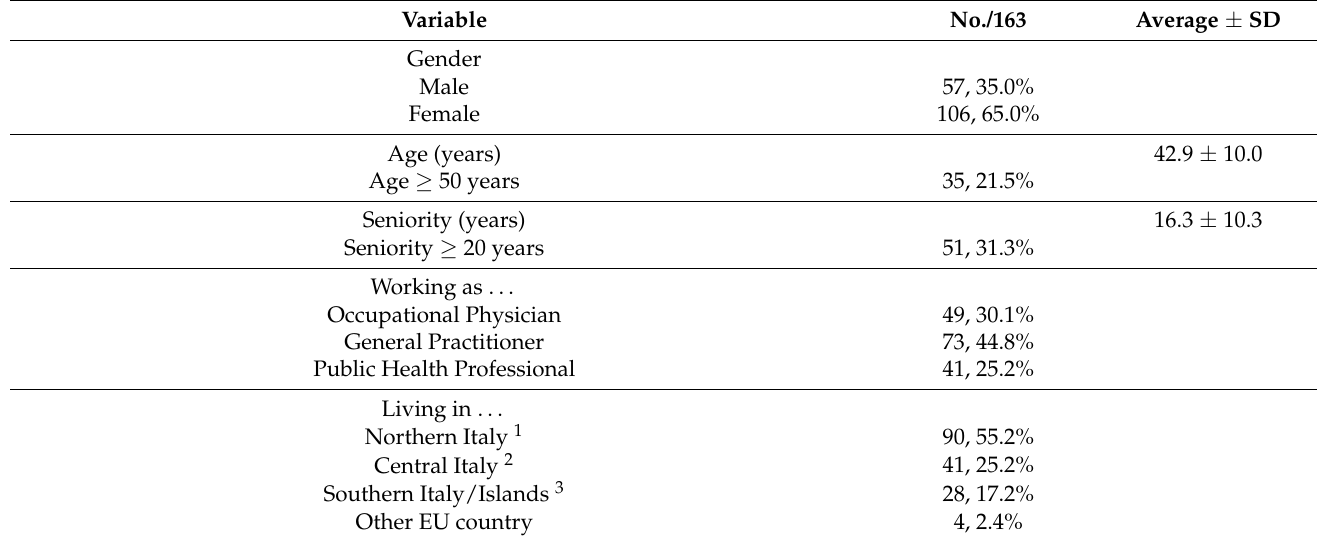
Table 1. Characteristics of the 163 Italian Physicians participating into the survey on knowledge, attitudes and practices on Monkeypox (MPX).